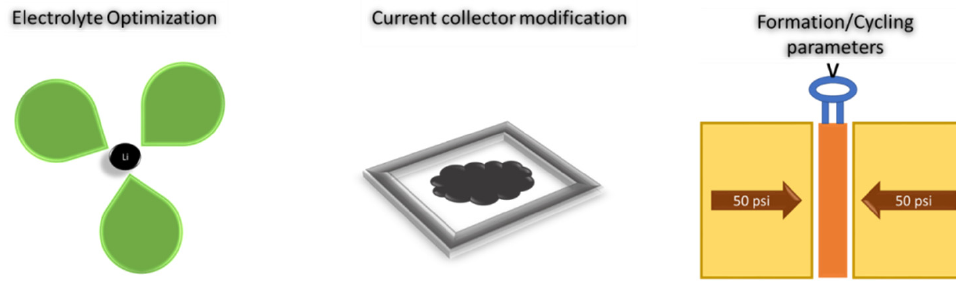
Figure 4. Framework indicating the three categories of strategies used to improve the performance of anode-free lithium-ion batteries (modified from [29]).